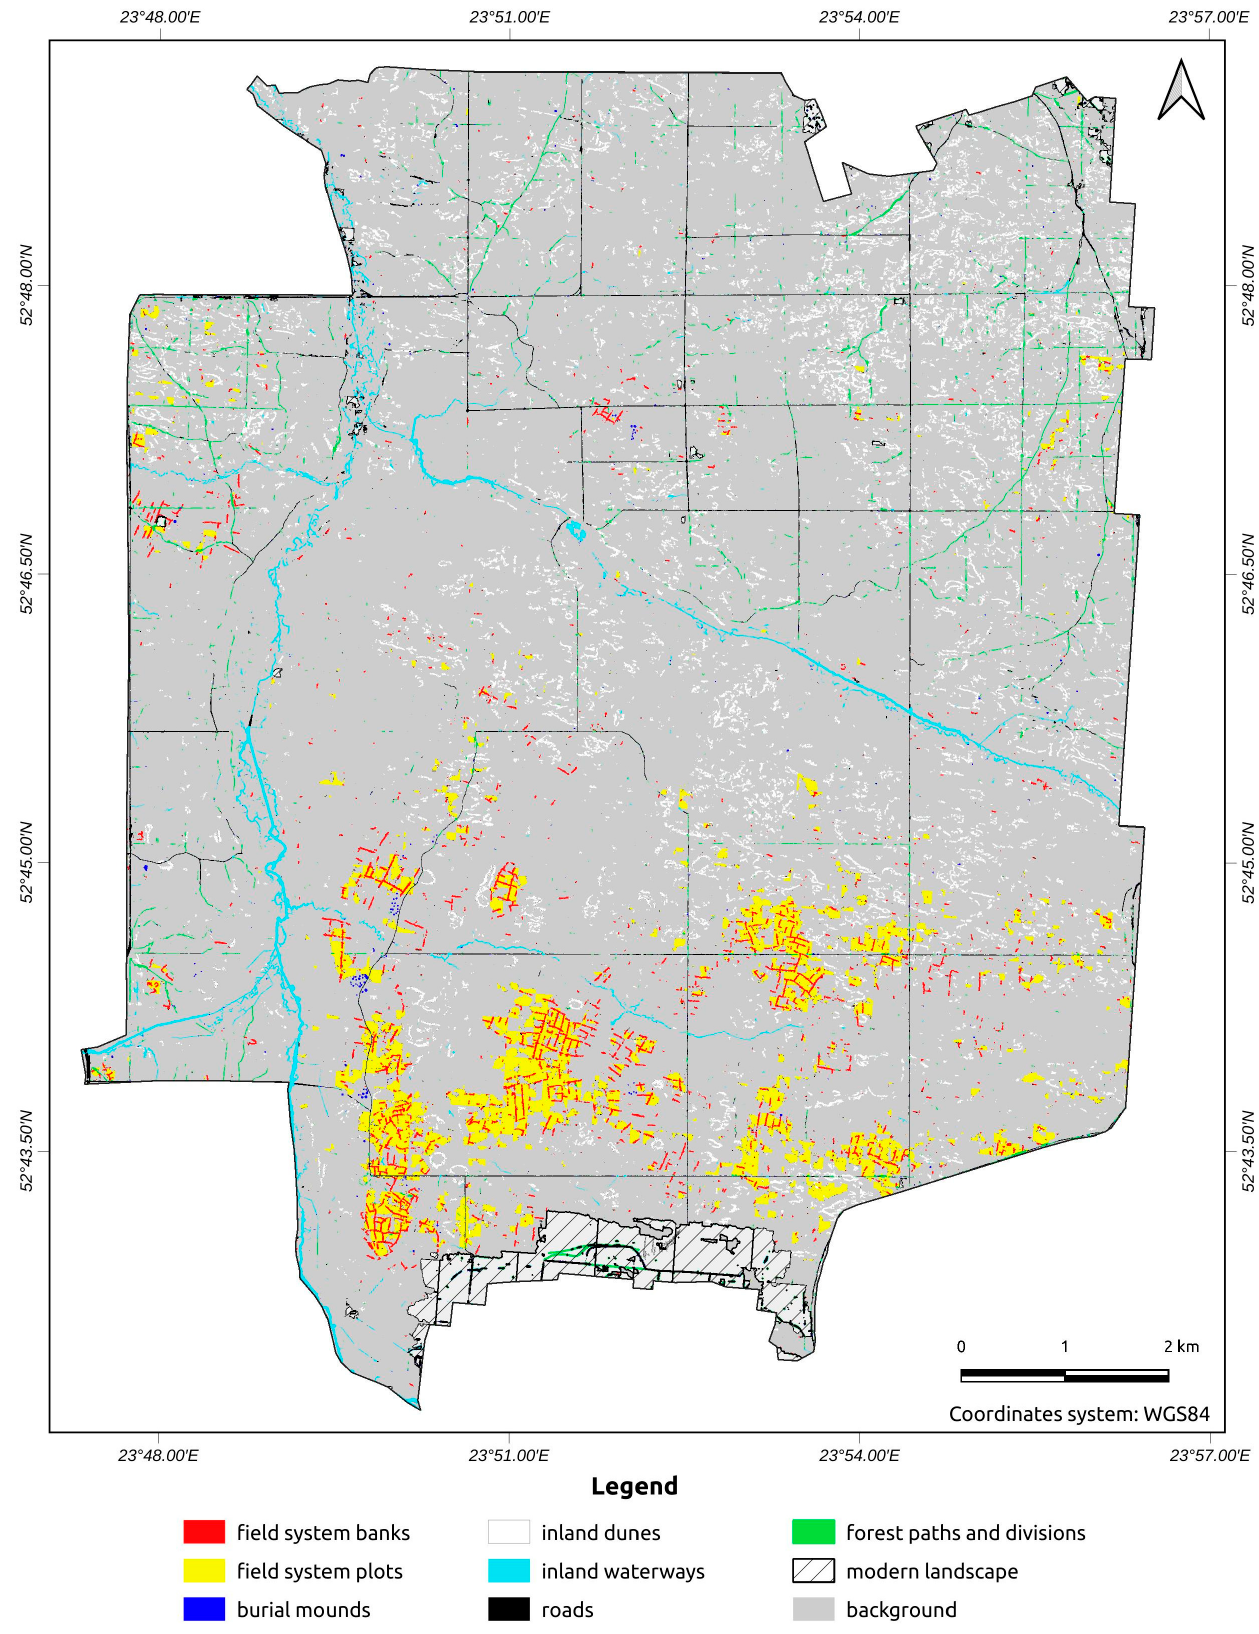
Figure 15. Semantic segmentation of the ALS data from the area of the Białowie˙za National Park by U-Net